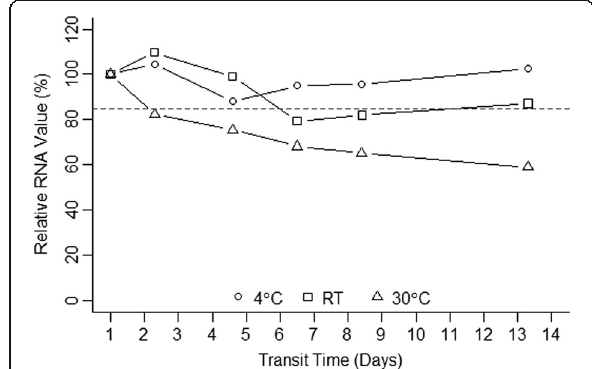
Fig. 5 Influence of temperature and time on RNA value using samples collected in stabilization buffer. The influence of RNA degradation on RNA level should not be greater than 15% as indicated by dotted line at 85%